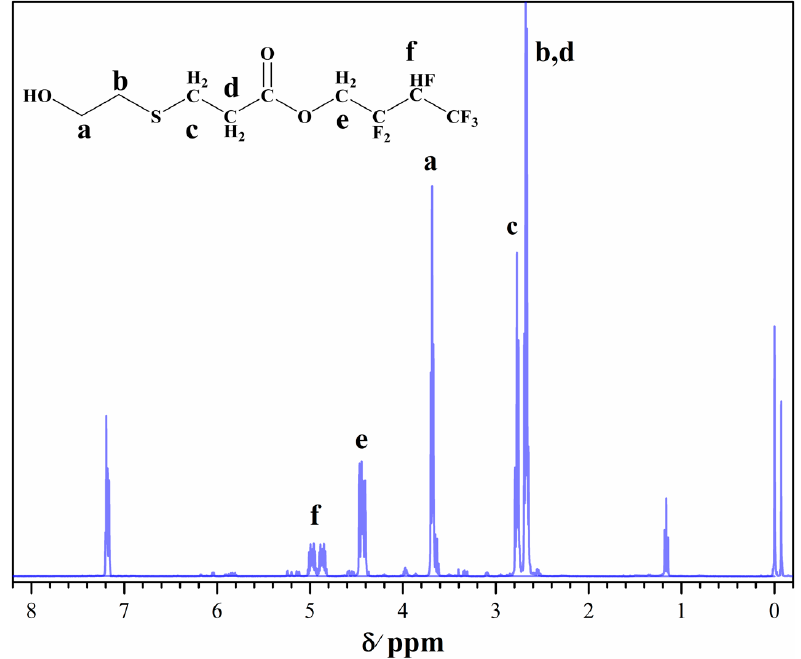
Figure 5. 1 H-NMR spectra of OH-G01.